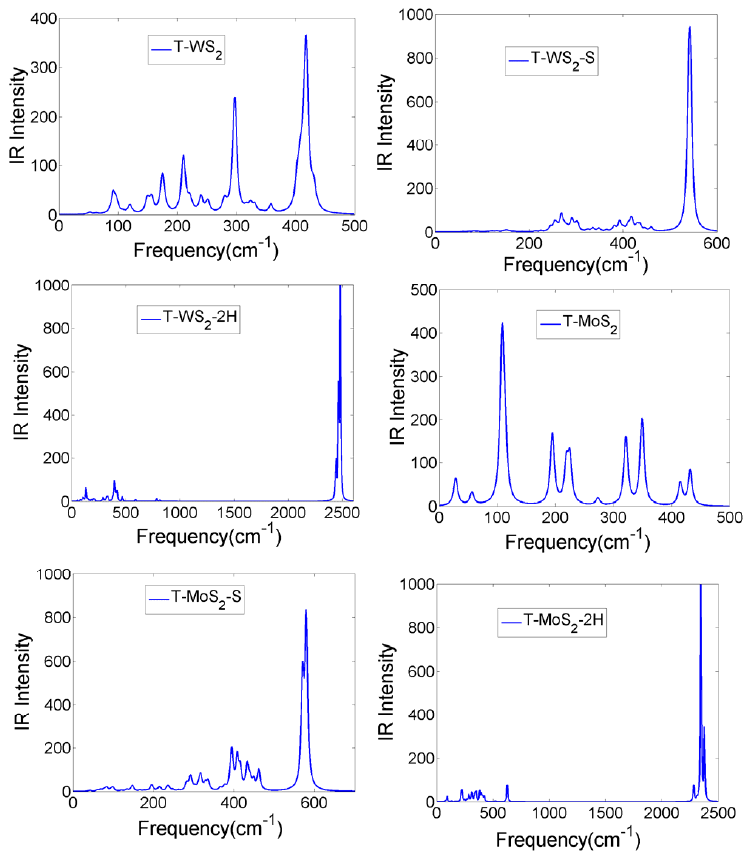
Figure A1. Infrared spectra of selected WS 2 and MoS 2 quantum dots before and after edge pas ‐ sivation.